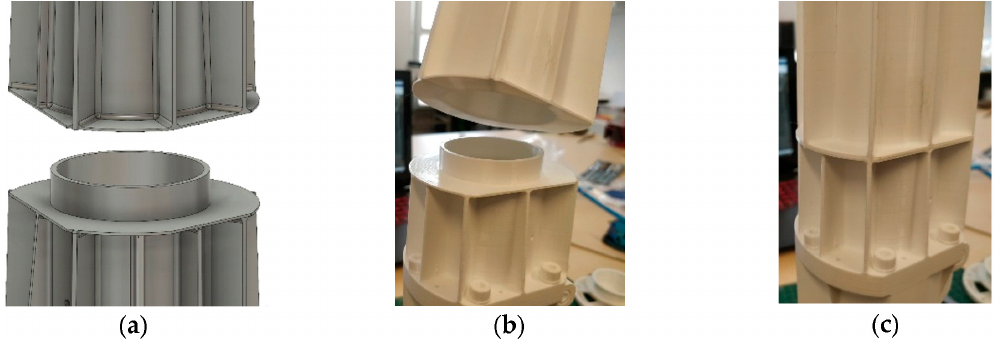
divided. ( b ) Piece printed in two parts. ( c ) View of assembled printed pieces.